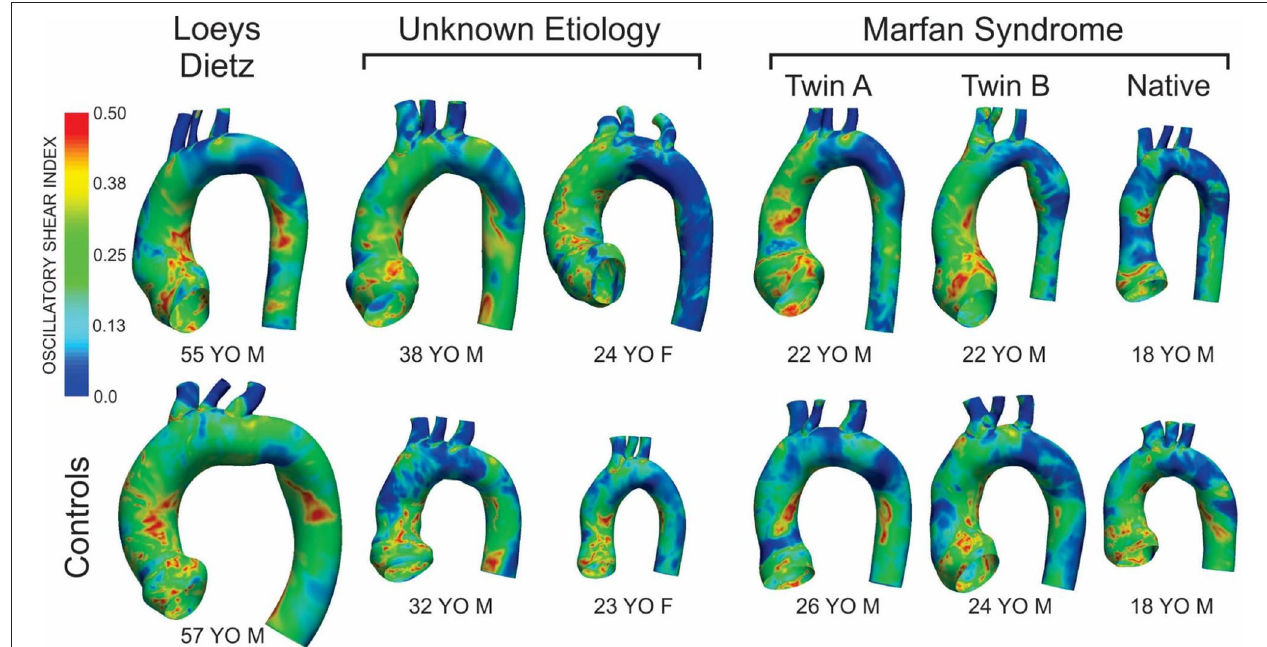
FIGURE 3 | Distributions of oscillatory shear index (OSI) for the six patients with the various connective tissue diseases studied (top row) and age- and gender-matched control participants to which each was compared (bottom row). The size of the models displaying the OSI results shown is relative to each other using the descending aortic outlet